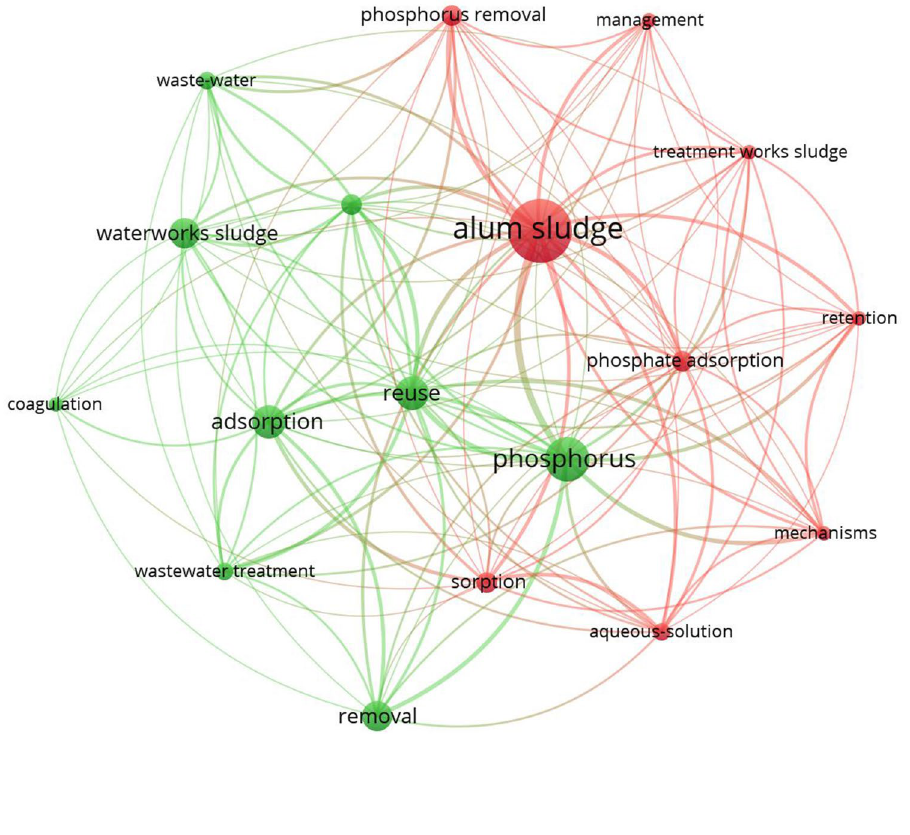
mapping through the last two decades based on overlay den- sity